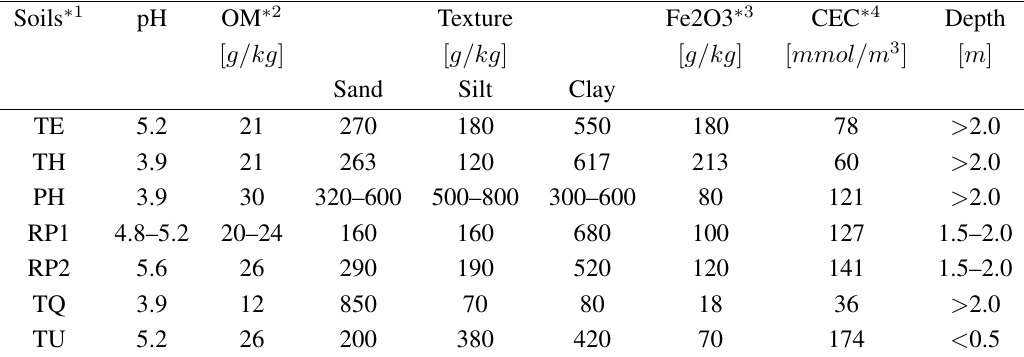
Table 1. Properties of the soil samples in the target region.